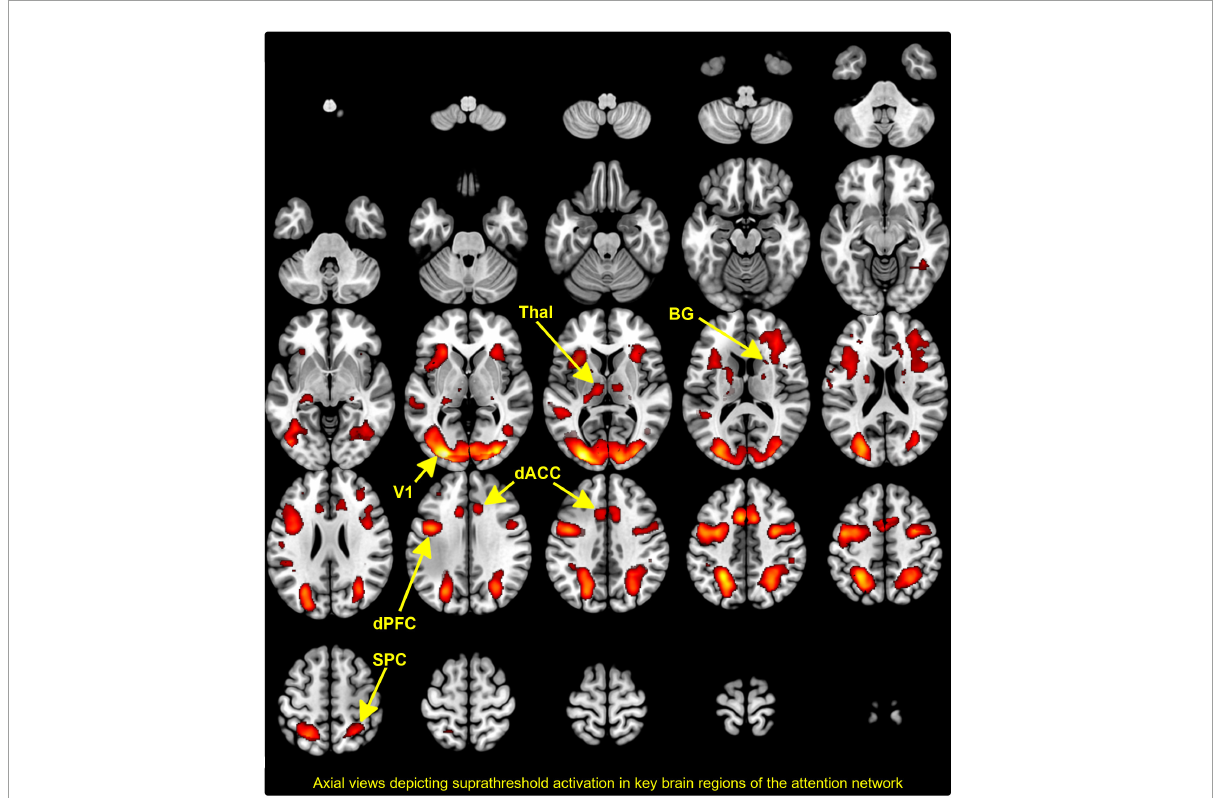
FIGURE2 The activation map depicts the results of conjunction analyses across group and condition with co-activated clusters projected to a mosaic of axial views. Supra threshold clusters are clearly seen in the thalamus, basal ganglia (BG), dorsal anterior cingulate cortex (dACC), dorsal prefrontal cortex (dPFC), superior parietal cortex (SPC), and visual cortex (V1). As we note, these sites are consistent with previously published evidence of the engagement of the attention